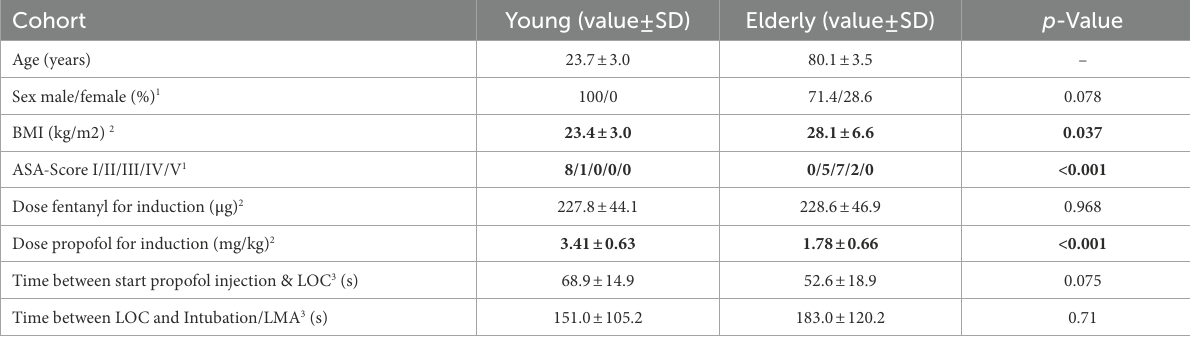
TABLE 1 Characteristics of the study